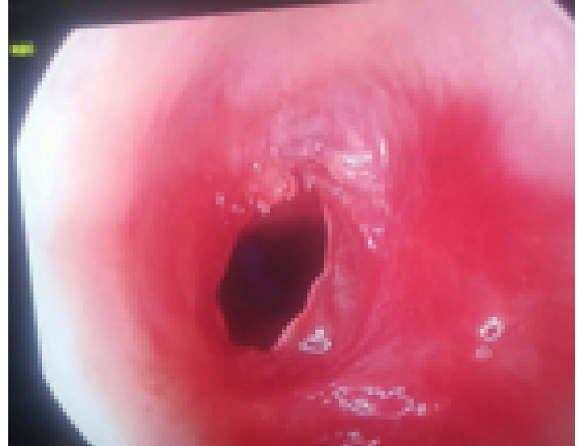
Figure 5: Postoperative endoscopic view of grade III subglottic stenosis after first sitting of bougie dilation.